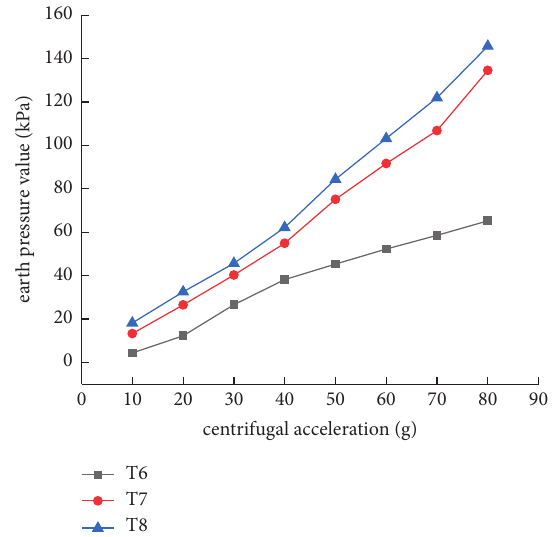
Figure 12: Variation curve of Earth pressure on the frame with